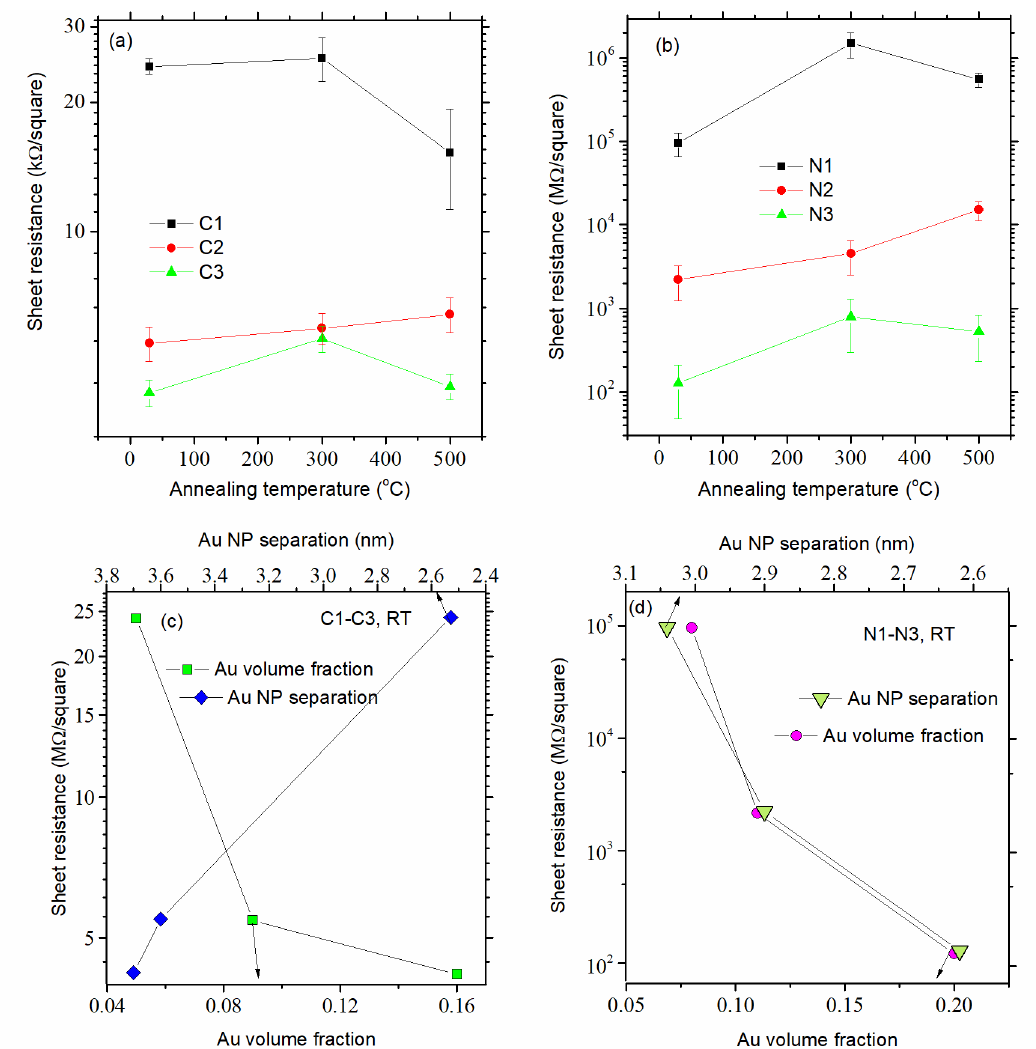
Figure 5. Sheet resistance as a function of annealing temperature of ( a ) SiC-based and ( b ) Si 3 N 4 - based films. Dependence of sheet resistance on Au volume fraction and averaged Au NP separation in ( c ) SiC-based and ( d ) Si N -based films.